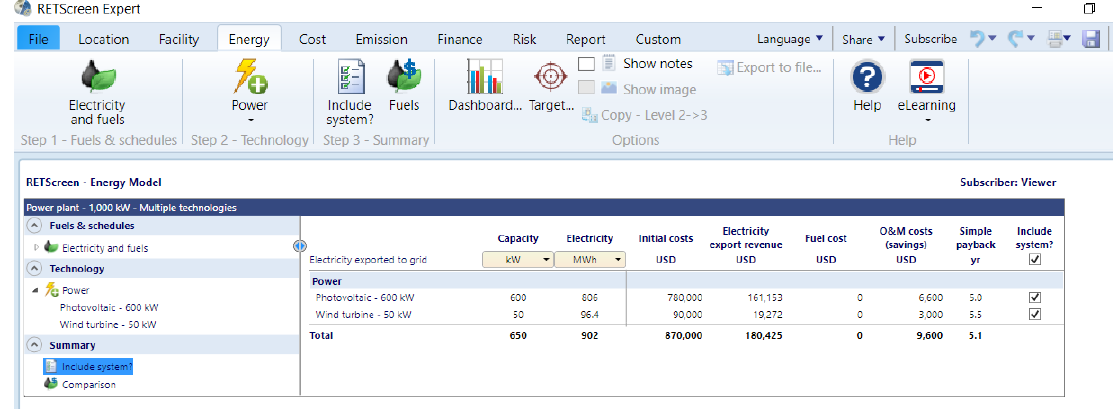
( b ) Figure 6. Okorobo-Ile town optimal: ( a ) PV orientation; ( b ) electricity generation. The facility location of the PV panels is hot due to the high sun intensity in the dry season. This has to be considered in the choice of PV panels. An investigation of a suitable choice of PV panels and their impact was performed. Six technologies were considered and compared. These included monocrystalline silicon (Mono-Si), polycrystalline silicon (Poly-Si), amorphous silicon (a-Si), cadmium telluride (CdTe), copper indium gallium se- lenium (CIS), and spherical silicon (spherical-Si). In investigating these technologies, at- tention was paid to the average operating cell temperatures, temperature coe ffi cient, and capacity factors. It was assumed that the initial costs (1300 USD), O&M costs (11 USD), and e ffi ciencies (18.05%) of each technology remained the same. Table 5 shows each technology’s nominal operating cell temperature (NOCT) and that a-Si and CdTe are healthy choices of technology options due to their high capacity factors of 15.3 and 14.9, respectively, and low sensitivities to temperature. This is shown graphically in Figure 7.